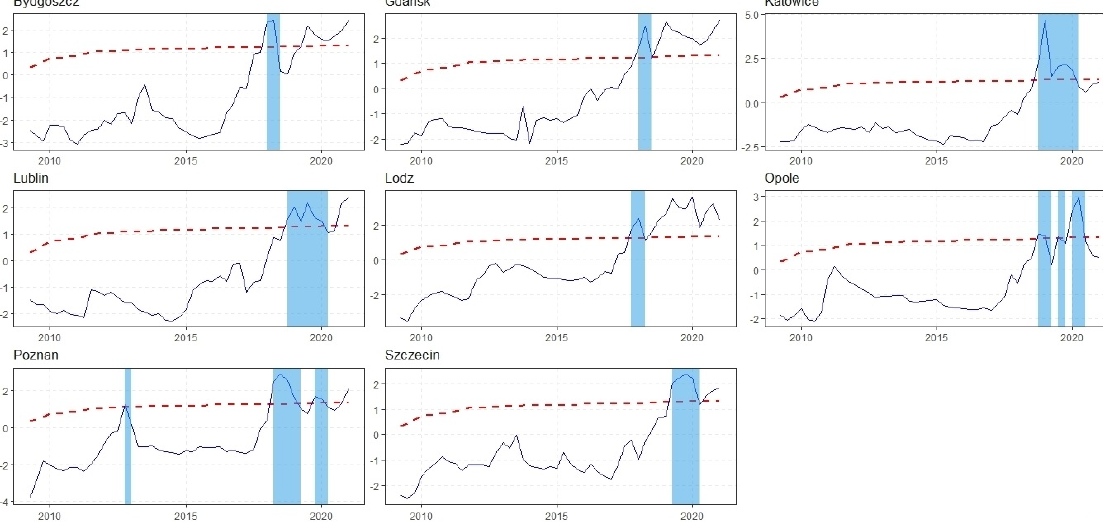
Figure 5. Graphical representation of episodes of price exuberance for a sample of eight Polish